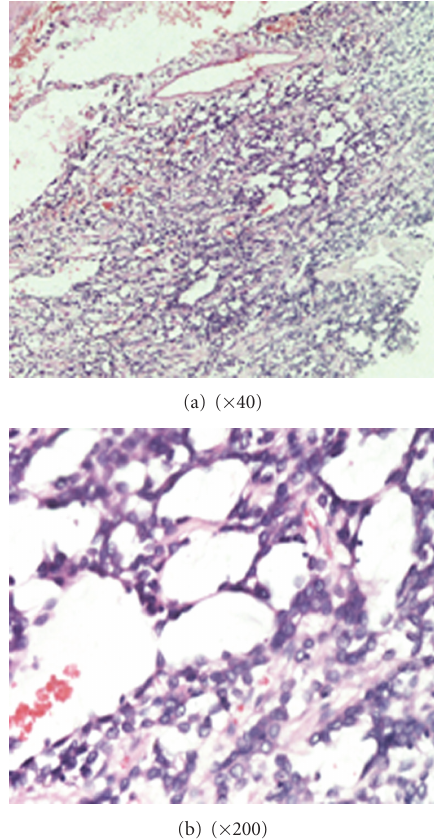
Figure 2: Histopathological microscopic structure of diaphragm angiosarcoma (tumor cell atypia, abnormal vessel-like cavities structure).